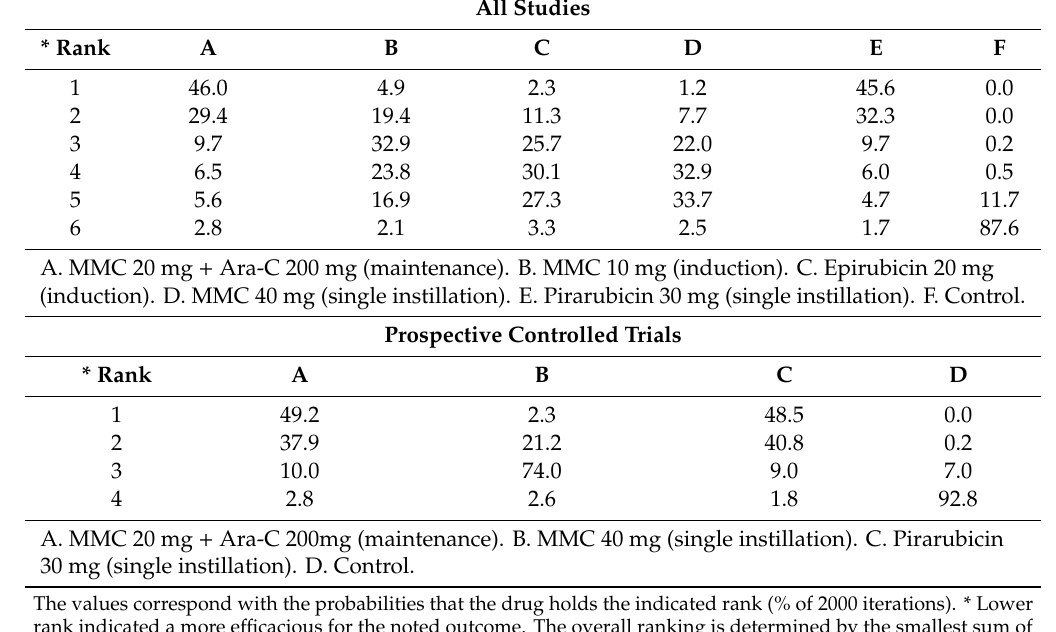
Table 3. Ranking of intravesical recurrence-free survival outcomes among chemotherapeutic agents. All